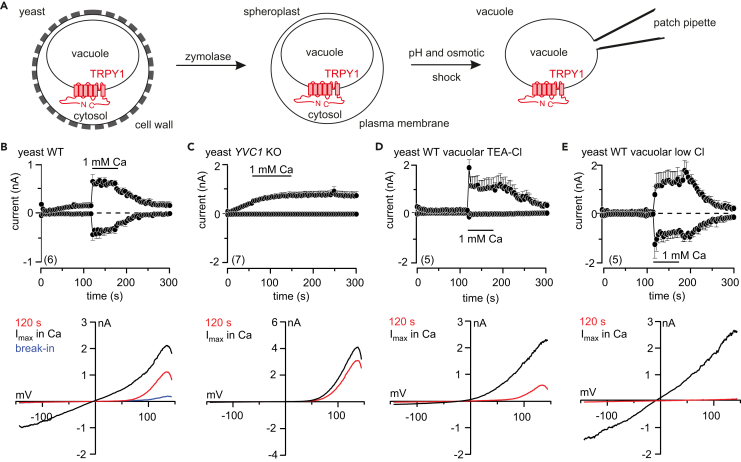
Cytosolic Ca2+ Activates Cation Conductance in Yeast Vacuoles via TRPY1(A) Procedure to release the yeast vacuole for patch-clamp experiments.(B–E) Inward currents at −80 mV and outward currents at 80 mV, extracted from 200-ms ramps (0.5 Hz) spanning from 150 to −150 mV, Vh = 0 mV, plotted versus time (top), and corresponding current-voltage relations (IVs) at break-in (blue), after 120 s (red) and at maximum current (Imax) in 1 mM cytosolic Ca2+ (black; bottom) measured in isolated vacuoles from wild-type (WT; B, D, and E) and YVC1-deficient (YVC1 KO; C) yeast. The membrane potentials refer to the cytosolic side, i.e., inward currents represent movement of positive charges from the vacuole toward the cytosol (Bertl et al., 1992a). 1 mM Ca2+ was applied to the bath (representing the cytosol) as indicated by the bars. In (D) K+ and in (E) Cl− were substituted by TEA+ (tetraethylammonium) and gluconate in the patch pipette, respectively. Currents and IVs are shown as means ± SEM and just means, respectively, with the number of measured cells indicated in brackets.